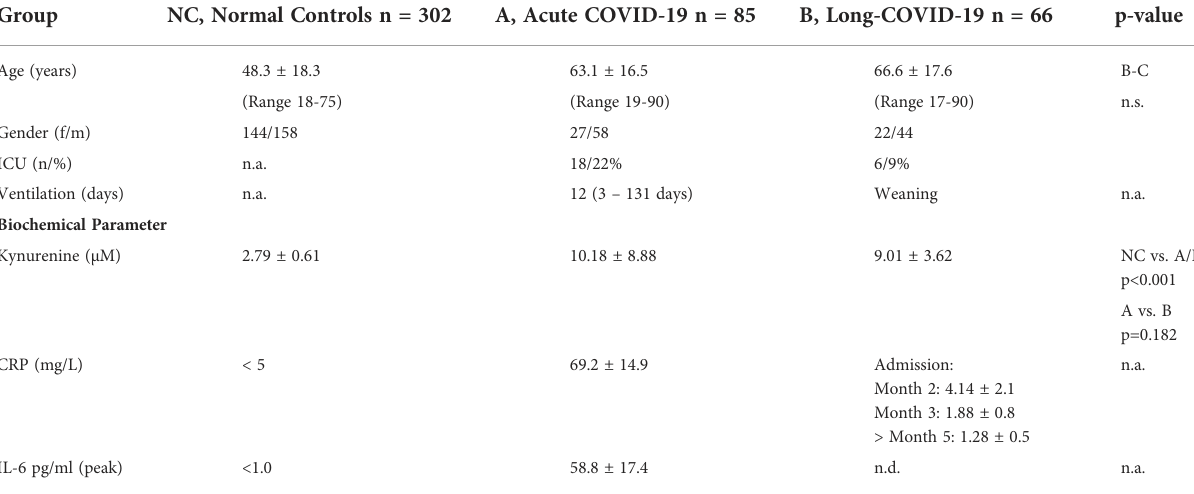
TABLE 1 Demographic and biochemical data of group NC, A, B.